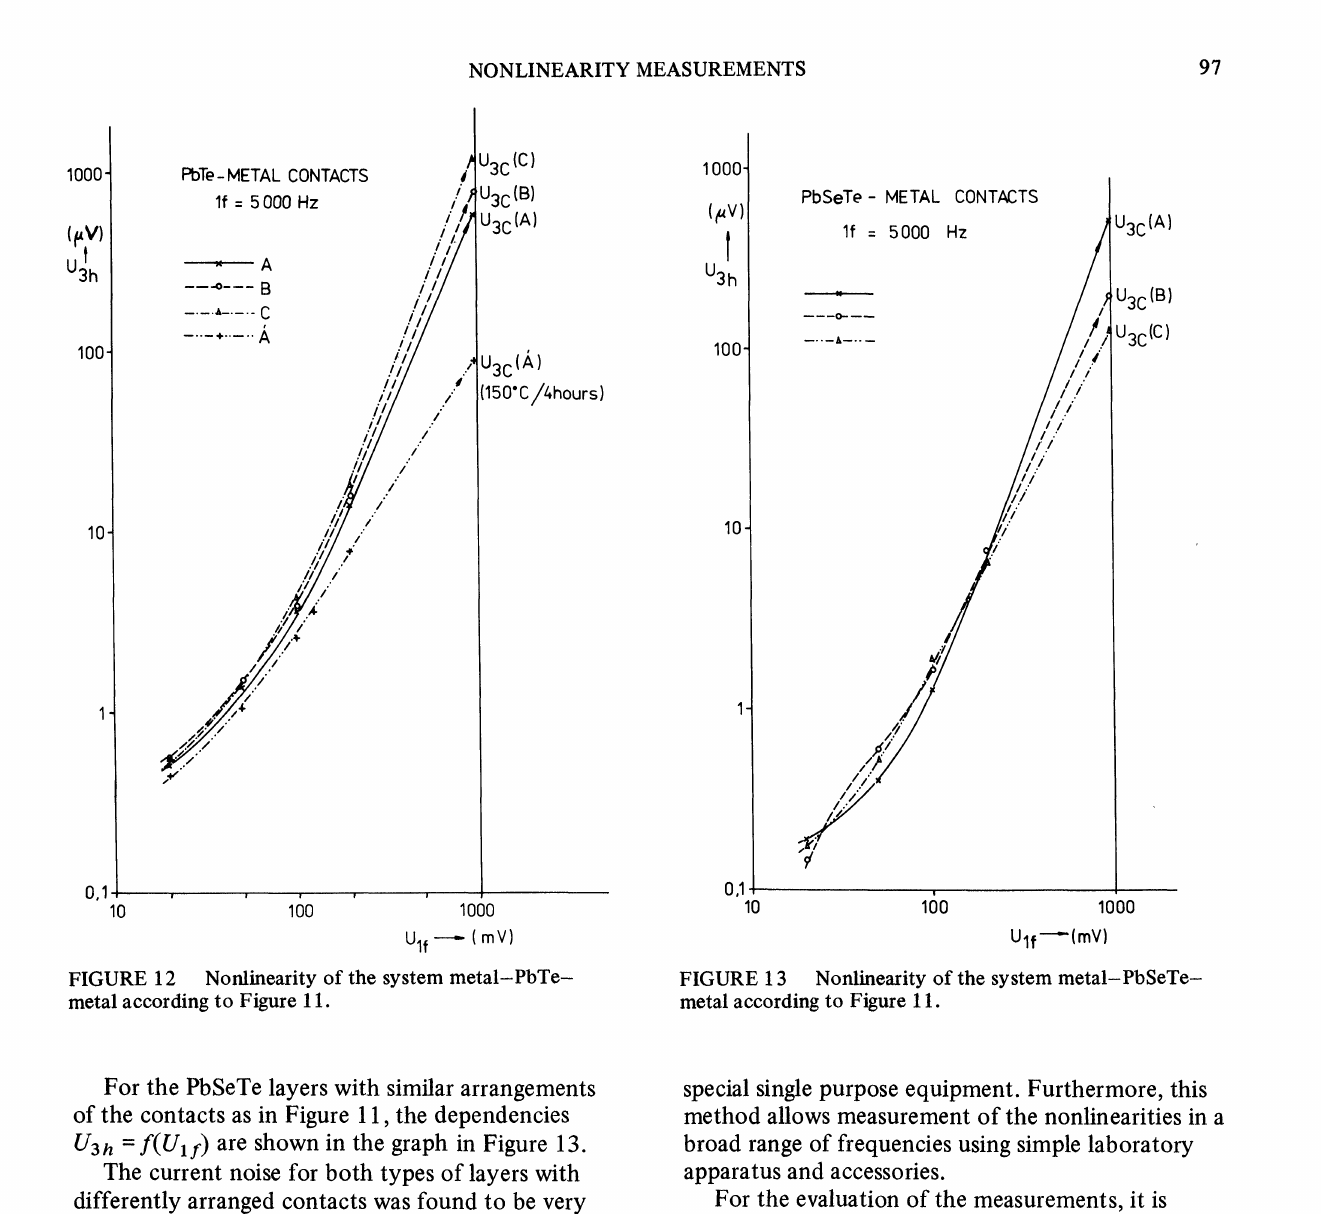
Nonlinearity of the system metal-PbSeTe- metal according to Figure